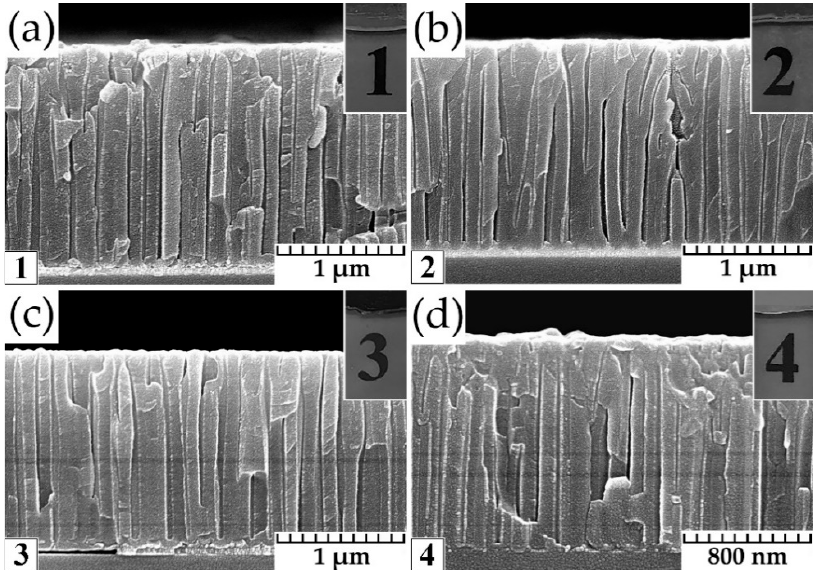
Figure 3. SEM images of cross-sections of quasi-ordered valve metals functional thin films on the glass substrate (samples 1–4), and their photos in daylight (on inserts): ( a ) Al/Ta oxide; ( b ) Al/Ta annealed oxide; ( c ) Al/Va oxide; ( d ) Al oxide obtained in the oxalic electrolyte. In contrast to the cross-section, for the surface, the influence of the electrolytes and sublayer on the structure is more pronounced (Figure 4).